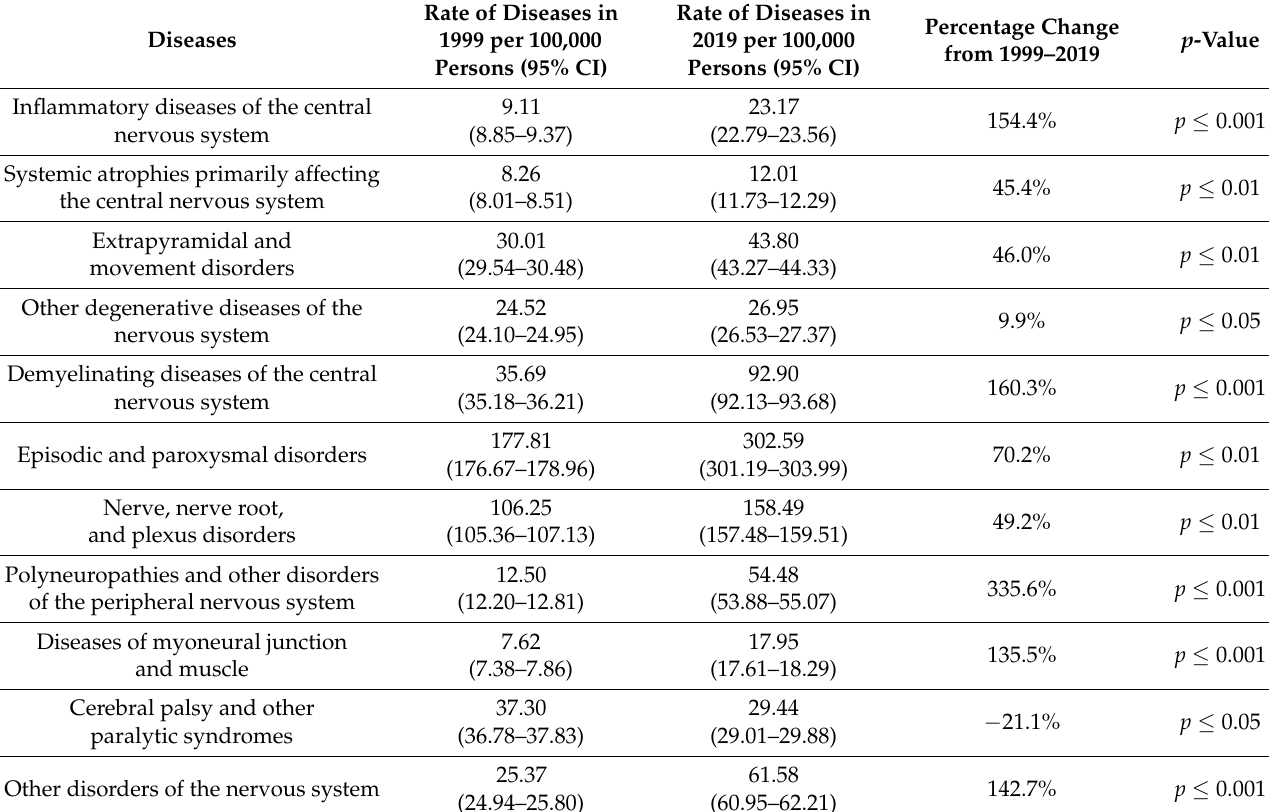
Table 2. Percentage change in the hospital admission rates for diseases of the nervous system from 1999–2019 in England and